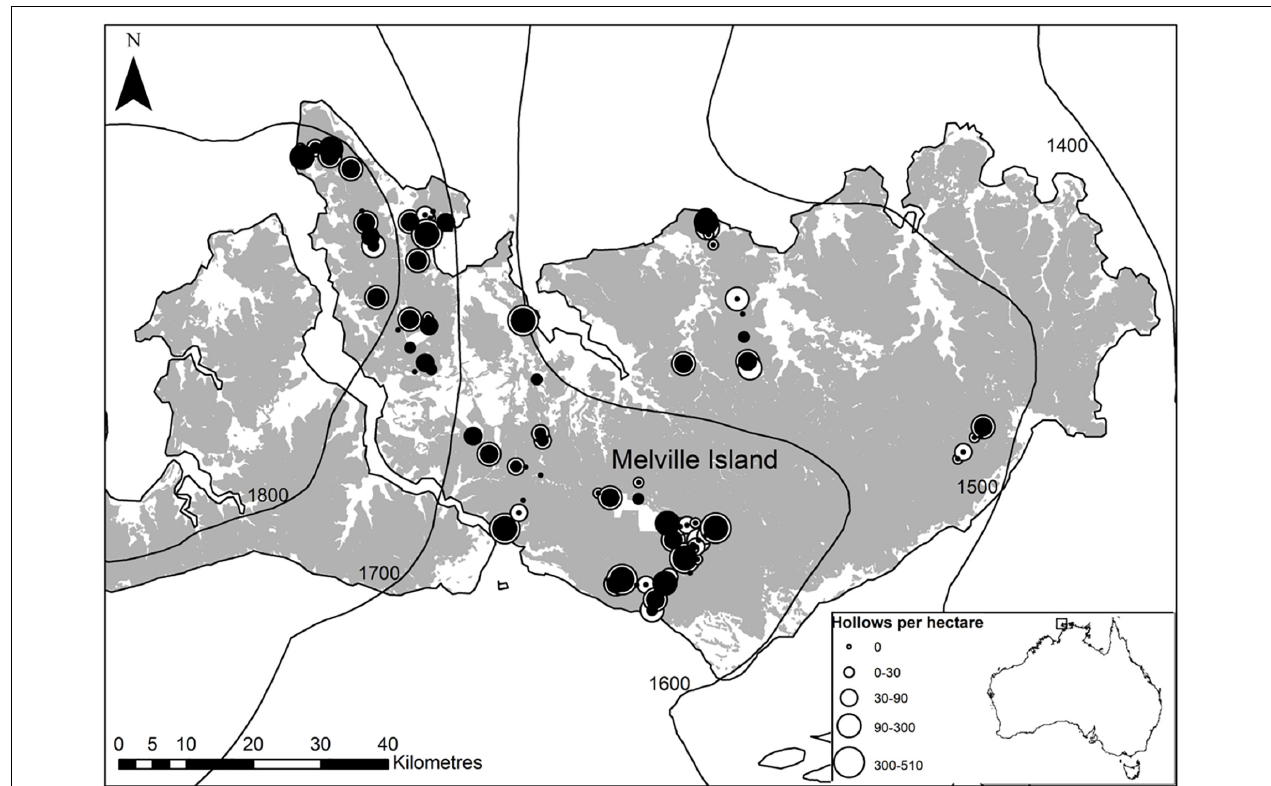
FIGURE 1 | Camera trap locations (Davies et al., 2018) and hollow surveyed sites (Penton et al., 2020a) across Melville Island, Northern Territory, Australia. Gray shading indicates eucalypt savanna and isohyets show the gradient in mean annual rainfall across the island. The diameter of the circles is proportional to the densities of hollows ≥ 5 cm entrance diameter in white and ≥ 10 cm entrance diameter in black at each